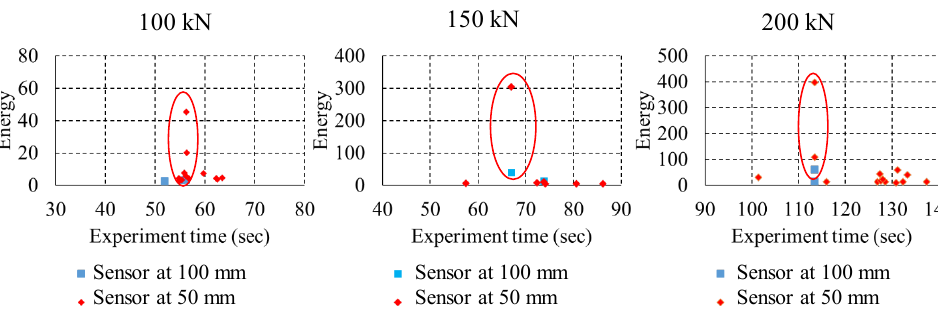
Figure 12. Experiment time vs. energy for AE signals in cluster 1 and 3.